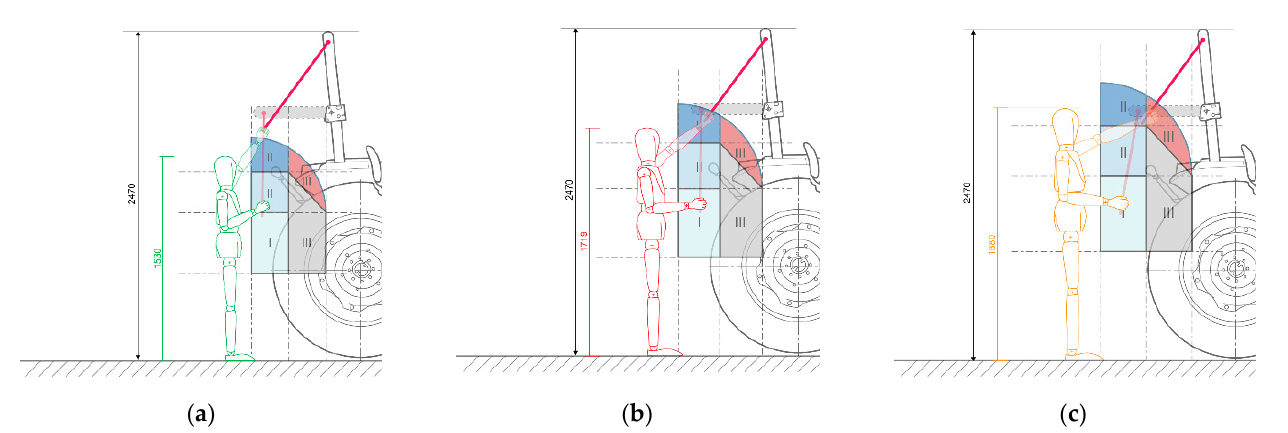
Figure 9. Sketches of the suggested solutions proposed, used by ( a ) the 5th percentile figure, ( b ) the 50th percentile figure, and ( c ) the 95th percentile figure, and its testing against the new accessible zones, to increase the users’ reachability for FROPS handling.